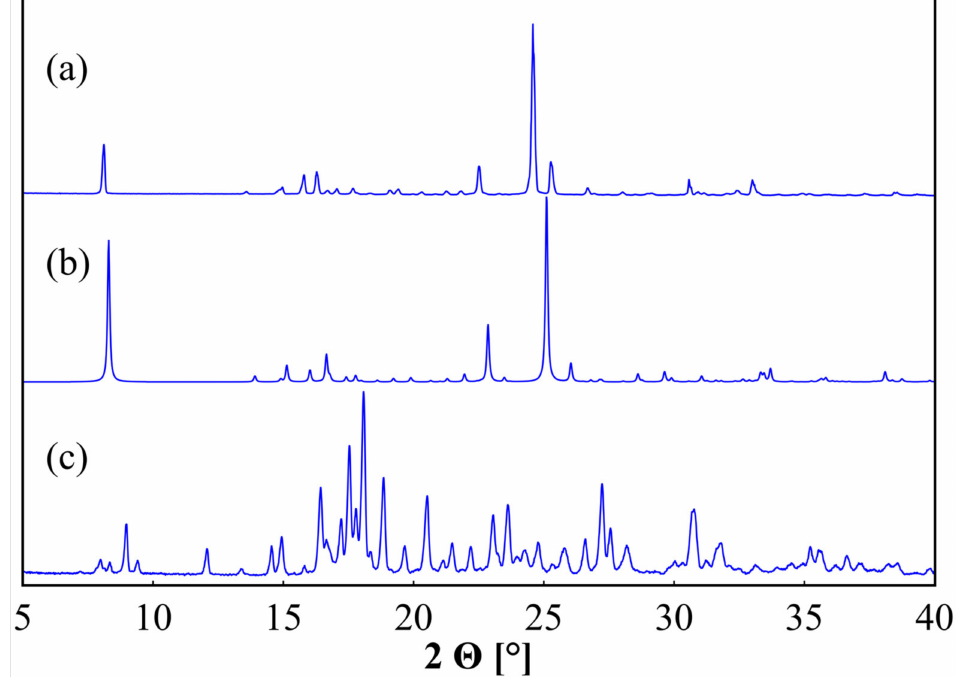
Figure 4. Powder patterns of 2 -based maleates. Sample of 2-MA • H 2 O obtained by solution crystal- lization ( a ), simulated pattern based on single crystal data ( b ), and a sample of 2-MA obtained by mechanochemical crystal synthesis ( c ). Powder patterns were recorded in a range of 5 ◦ –40 ◦ 2 Θ